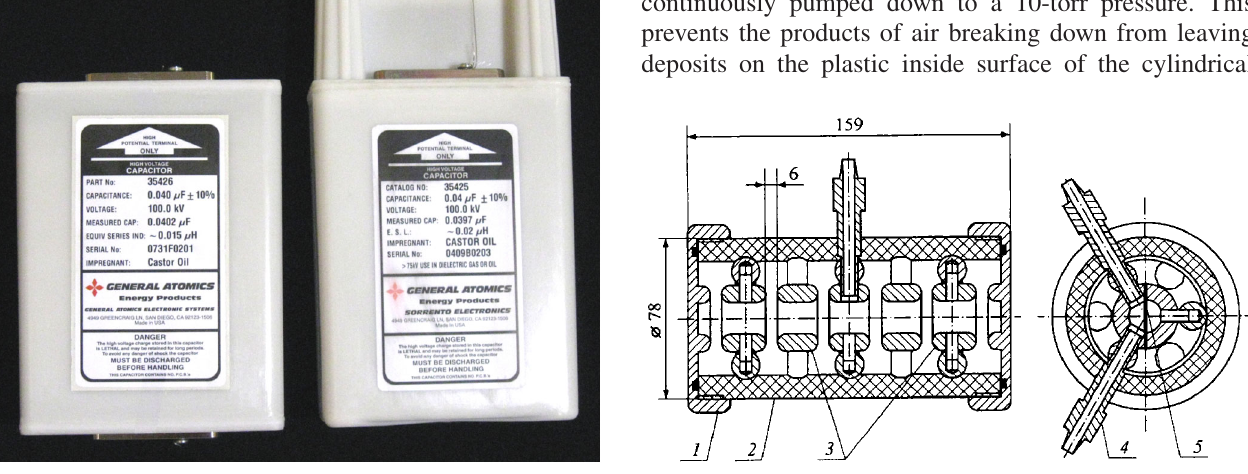
FIG. 5. Schematic diagram of the LTD cavity switch. The operating maximum voltage is (cid:2) 100 kV and the maximum current 25 kA. The switch components are: 1—cover flange; 2—cylindrical nylon housing; 3—spark gap electrodes; 4—tube for inlet and outlet; 5—rod holder of corona voltage grading needles. The dimensions are in mm. The cross section of the switch is taken through the middle electrode [11].